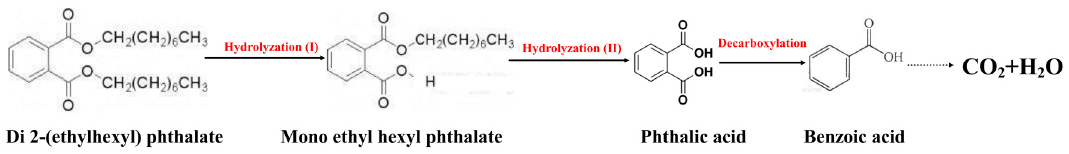
Figure 8. The proposed degradation pathway of DEHP. DEHP was hydrolyzed to phthalic acid (PA) via the intermediate MEHP. BA was metabolized for cell growth through the benzoate metabolism pathway.